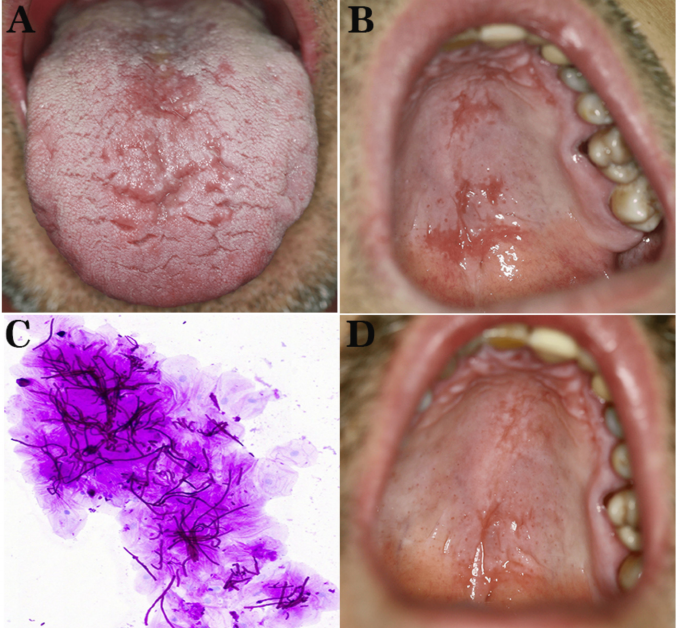
Figure 5. Patient 3. ( A , B ): Clinical examination: scattered erythematous areas on the dorsal tongue ( A ) and hard palate ( B ). ( C ) Cytology smear from the dorsal tongue showing yeasts of Candida albicans (PAS staining, 200 × ). ( D ) Clinical examination one week after the commencement of antifungal treatment showing significant remission of the palatal